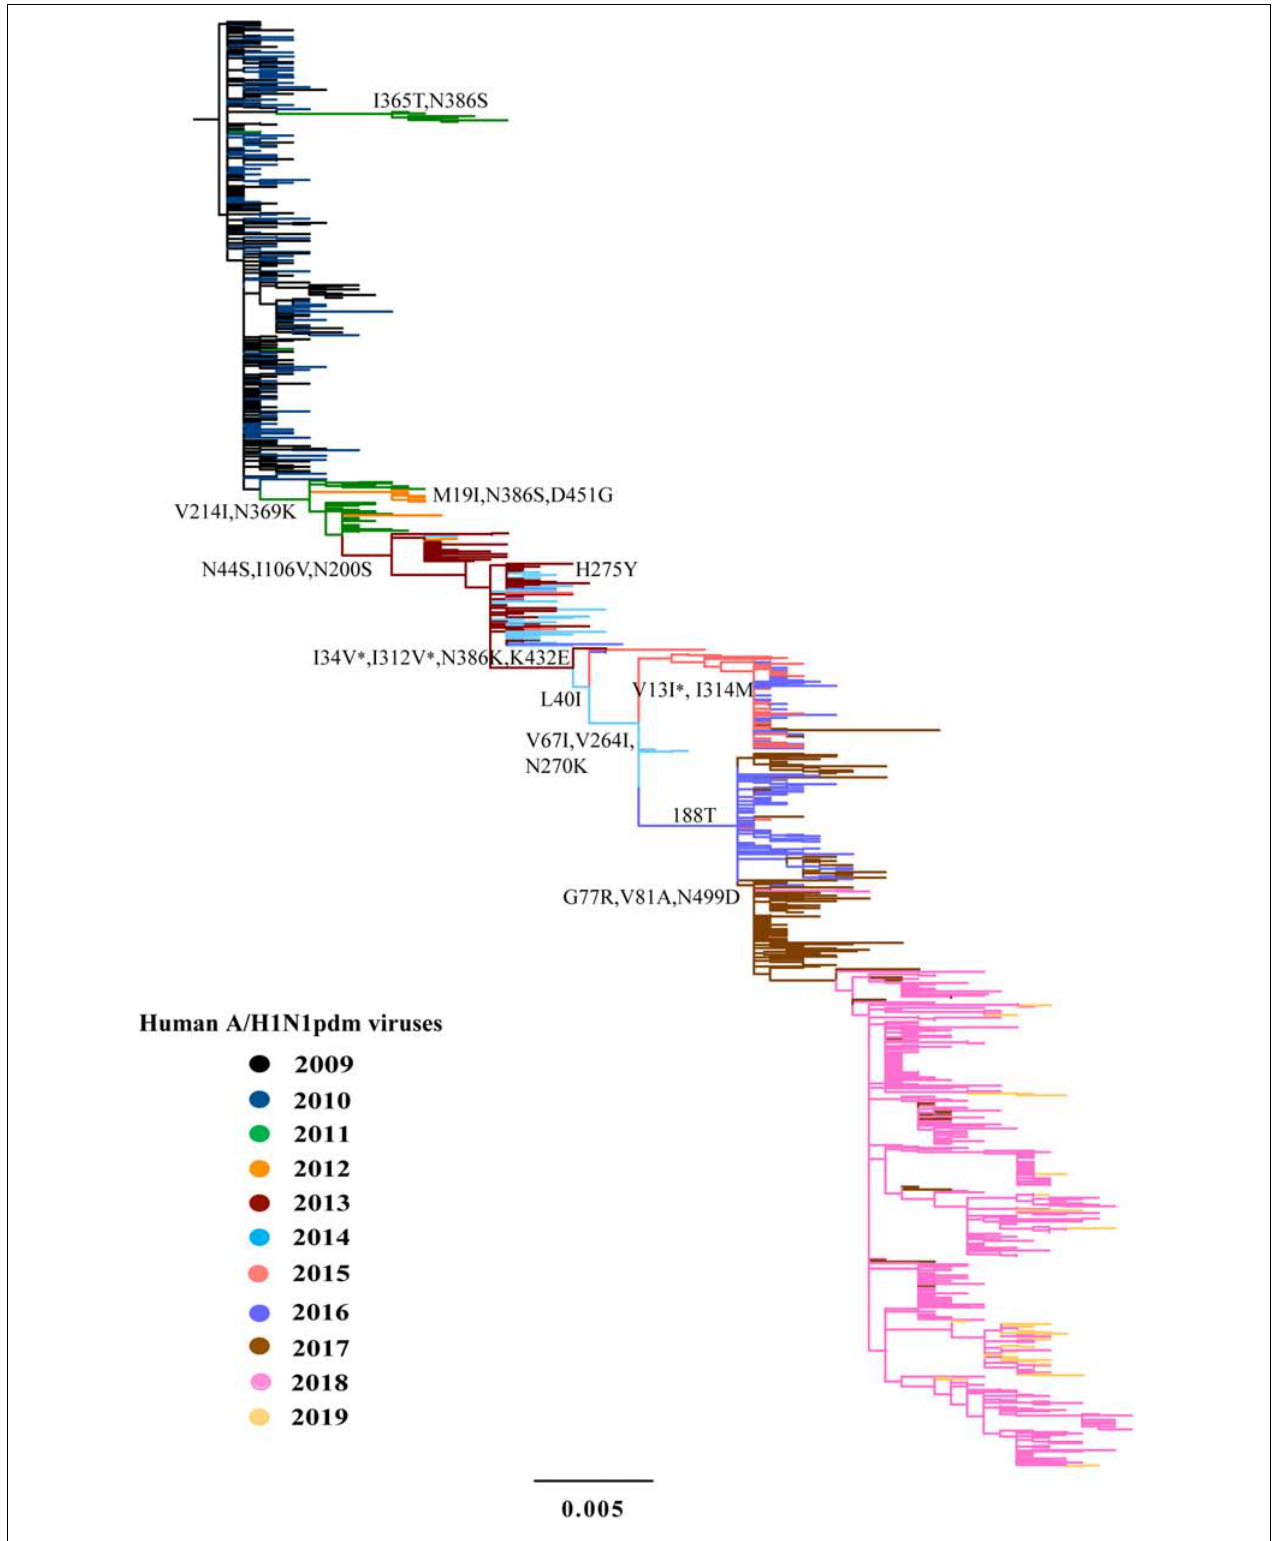
FIGURE 3 | Phylogeny of A/H1N1pdm virus by NA gene. The ML tree inferred from 1043 A/H1N1pdm virus NA sequences in China from 2009 to 2019. The color of the branch is marked by the isolation year of the strain. Fixed amino acid mutations are mapped at the major nodes of the tree. Positively selected sites are highlighted by asterisks